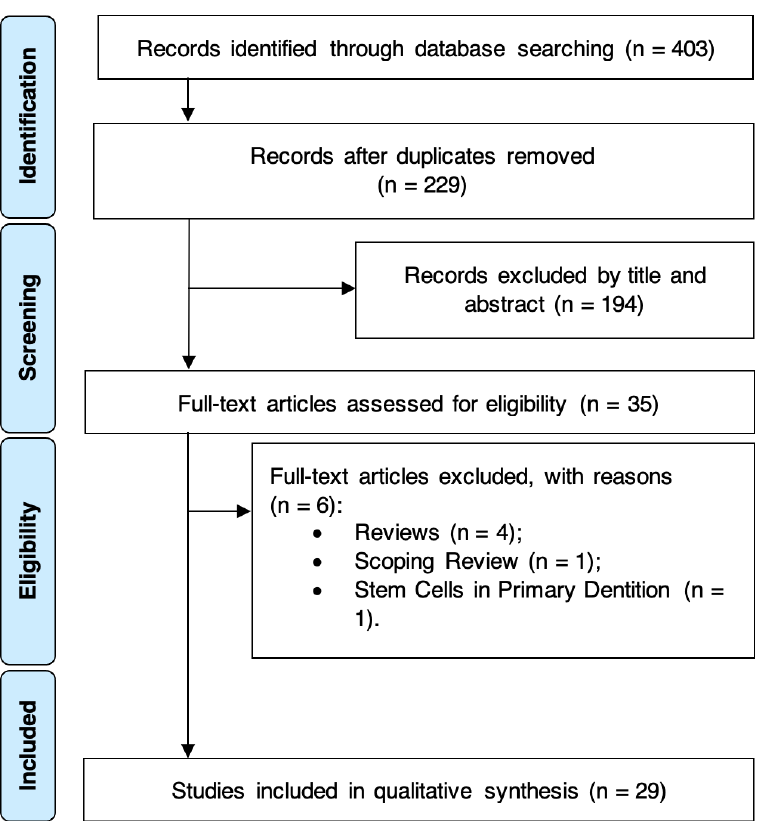
Figure 1. PRISMA diagram showing the exclusion and inclusion process of the literature review.